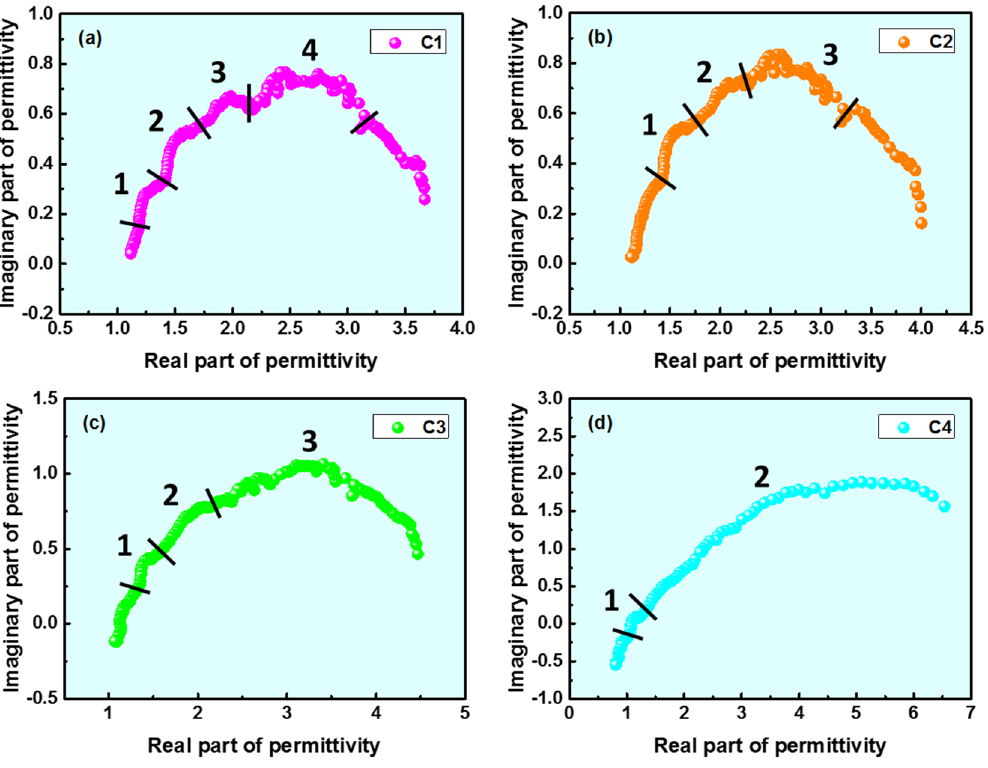
Figure 7. Cole-Cole curves of C1 ( a ), C2 ( b ), C3 ( c ) and C4 ( d ). In terms of magnetic loss, domain-wall resonance occurs in the MHz range and the hysteresis dissipation in weak field could be neglected. The remaining exchange and nature resonance, and eddy-current loss take play in GHz range, in which the eddy- current loss effect is characterized by the C 0 parameter [45,46]: